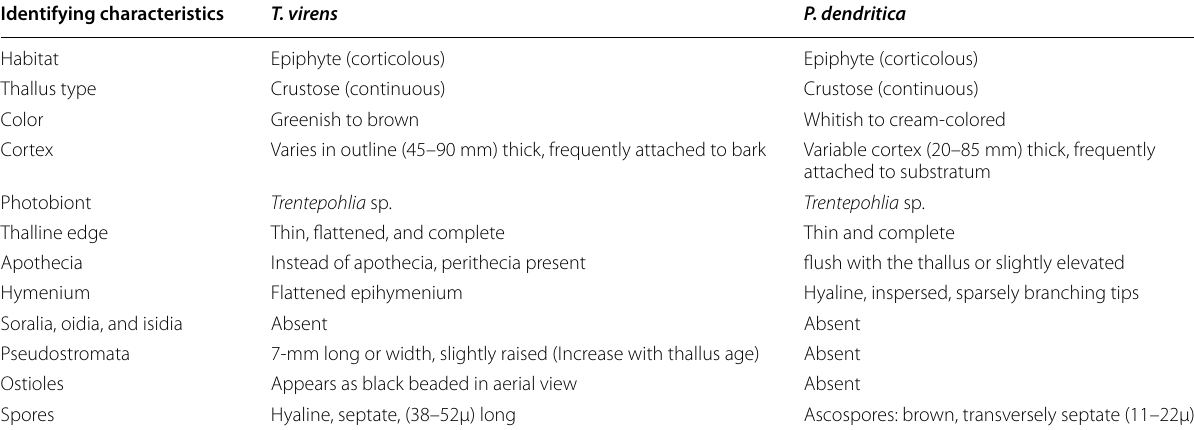
Table 2 Morphological characteristics of lichens